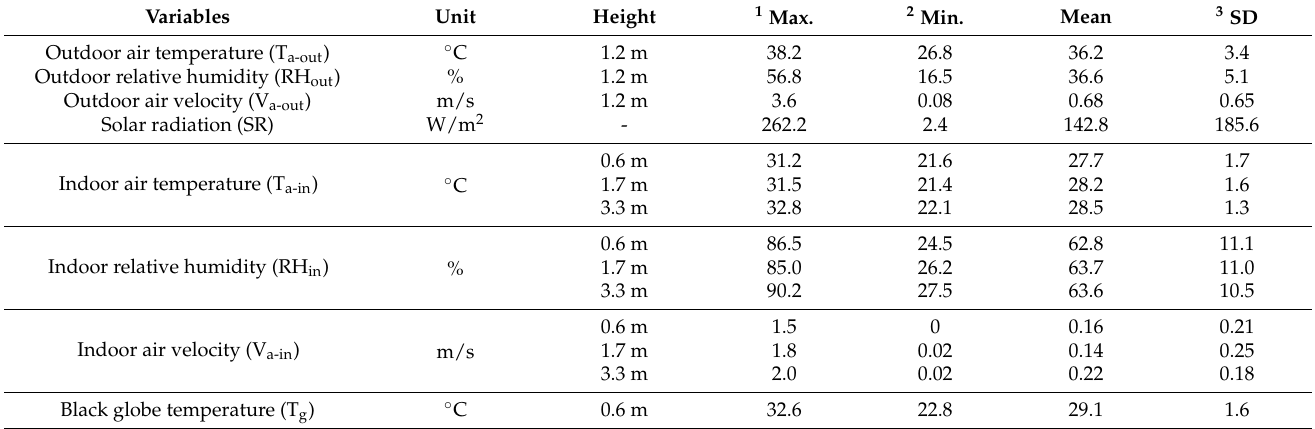
Table 6. The measured results of outdoor/indoor environmental